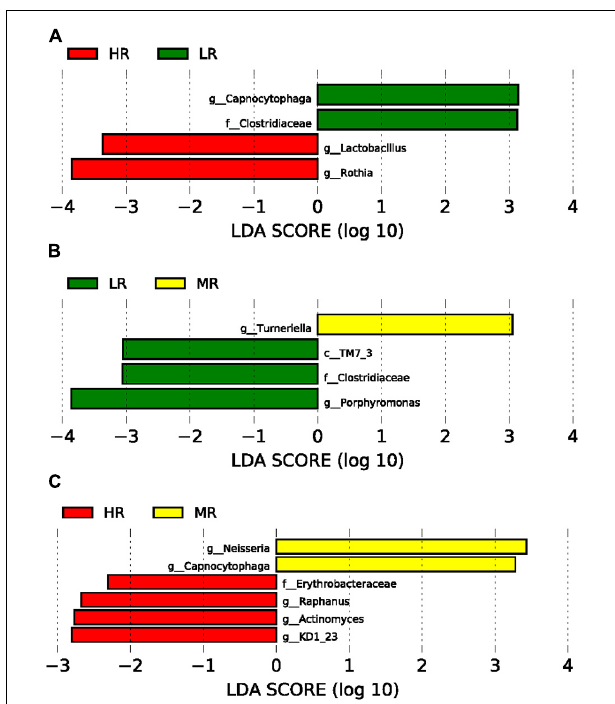
FIGURE 3 | Graphs of linear discriminant analysis (LDA) scores for differentially enriched bacterial genera among the groups. (A) LR (green) vs. HR (red) groups; (B) LR (green) vs. MR (Yellow) groups; (C) HR (red) vs MR (Yellow)